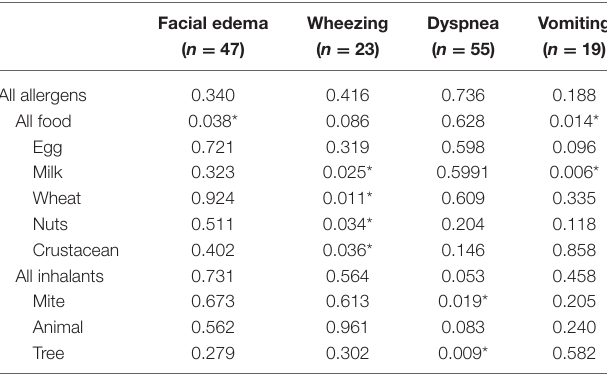
TABLE 3 | P -values of the Chi-square tests that analyzed the association between the symptoms of anaphylaxis and the type of allergen sensitization ( n = 74). Facial edema Wheezing